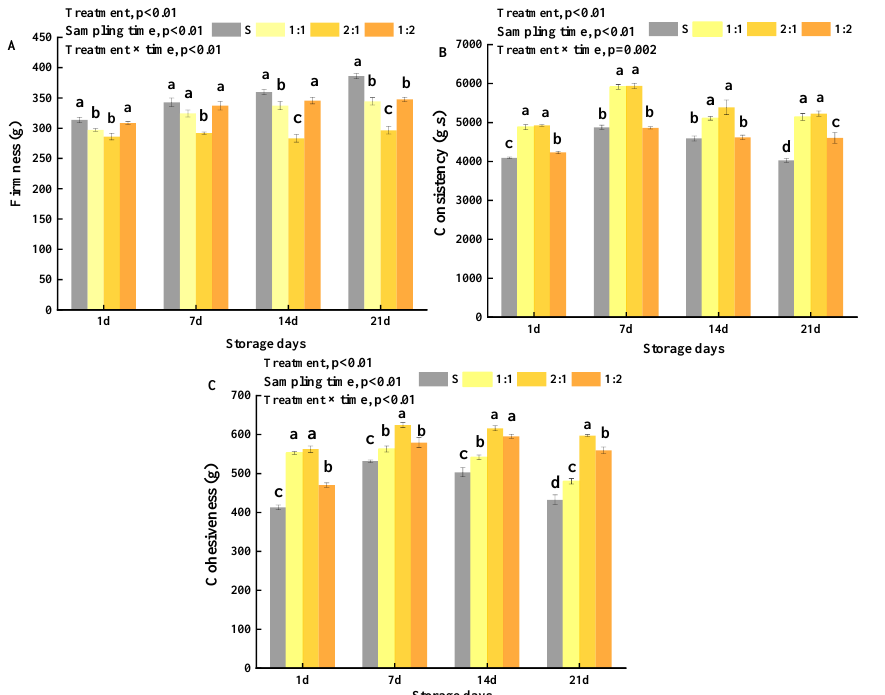
Figure 5. Texture properties of yogurt were added with different proportions of MC5 during storage. ( A – C ) Firmness, consistency, and cohesiveness of yogurt, respectively. Error bars represent the standard errors (se) of the model-fitted mean value ( n = 3). “a, b, c, d” indicate significant differences within yogurt groups during storage at p < 0.05.